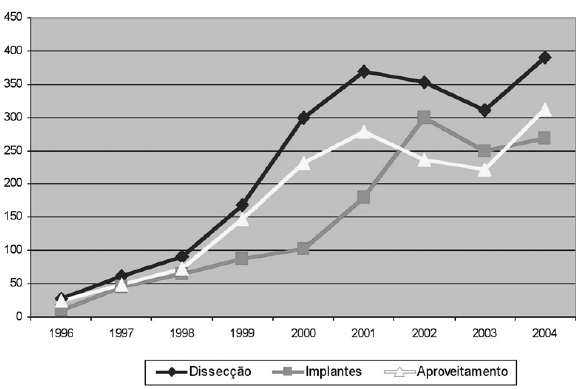
Fig. 6 - Relação temporal entre o número de enxertos processados, liverados para uso clínico e